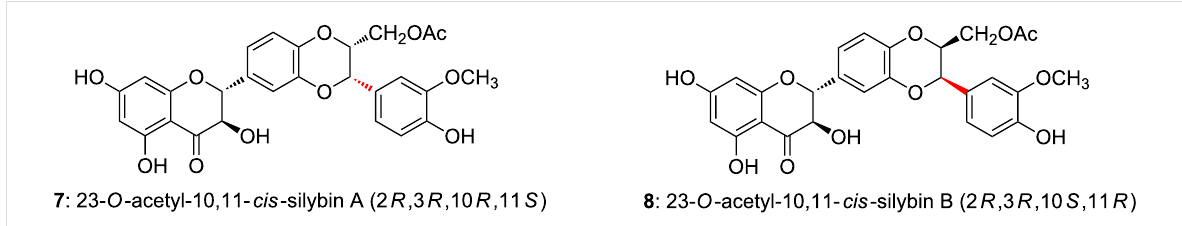
Figure 3: Structures of cis -derivatives obtained by the isomerization of 1 using BF 3 ·OEt 2 in EtOAc.